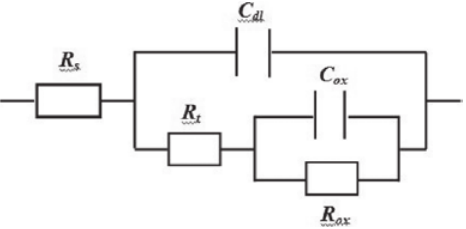
Fig. 4: Equivalent circuit representing the corrosion of porous Cu-3mass%Ni-(5,10)mass%Cr in molten (0.62Li,0.38K) 2 CO 3 at 650 °C in